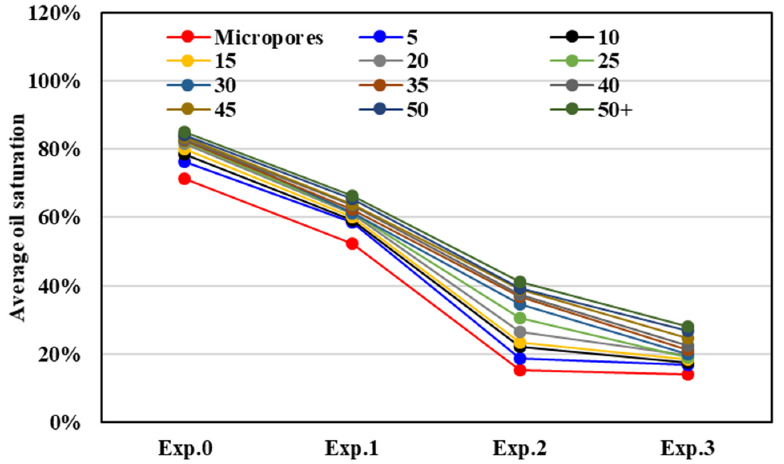
Figure 17. Variation of the average oil saturation in pores of different equivalent radius.